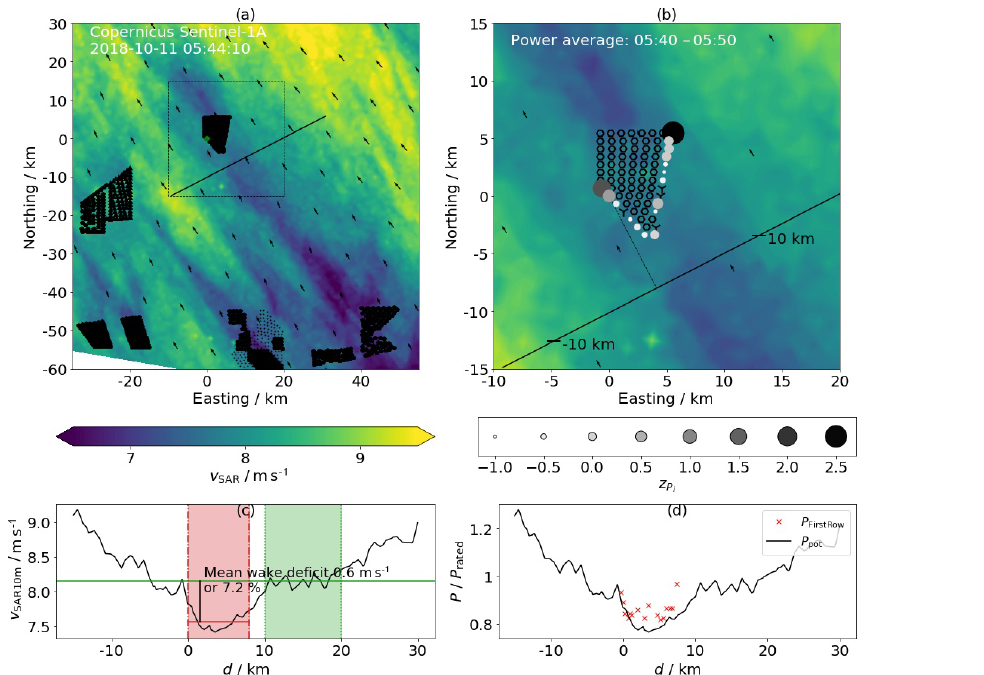
Figure 9. Sentinel-1A Ocean Wind Field (Copernicus Sentinel data (2018)); measurement taken 11 October 2018 05:44:10UTC. We show power data of the upstream turbines in the interval 05:40–05:50UTC, as in Fig. 5; positions of downstream turbines are marked (hexagon). In (d) we added an offset of 2.0ms − 1 to the SAR wind speeds on the virtual wake cut 9000m upstream of GT58 before we transferred them to hub height and calculated the potential power. Numbers of considered upstream turbines to calculate the z score are 8, 15, 22, 29, 36, 43, 50, 68, 72, 80, 79, 76, 73, 64, 58, and